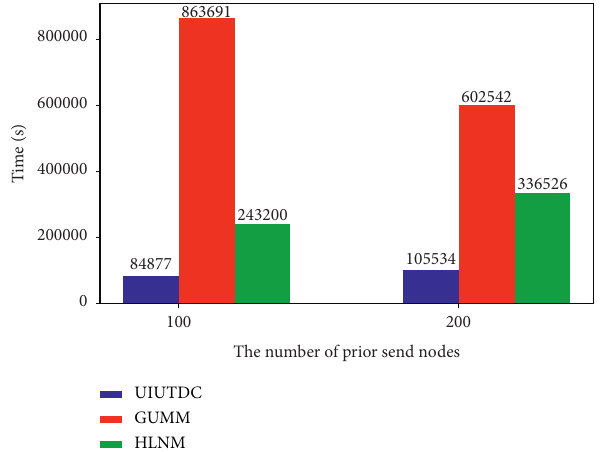
Figure 9: Comparison of running time of different seed nodes.